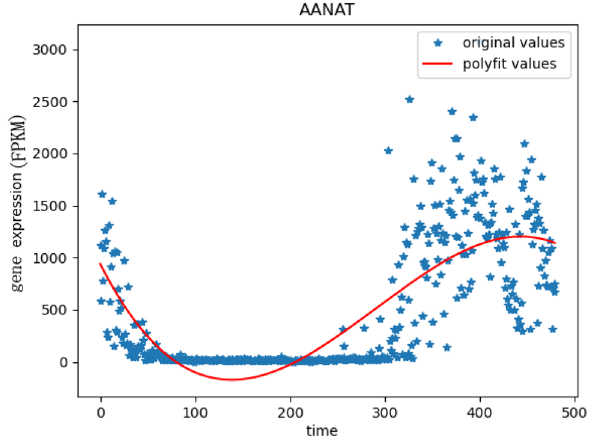
Figure 9. The change trend of AANAT gene expression. The red curve represents the fitting curve, and the stars represent the expression value at the point of time.